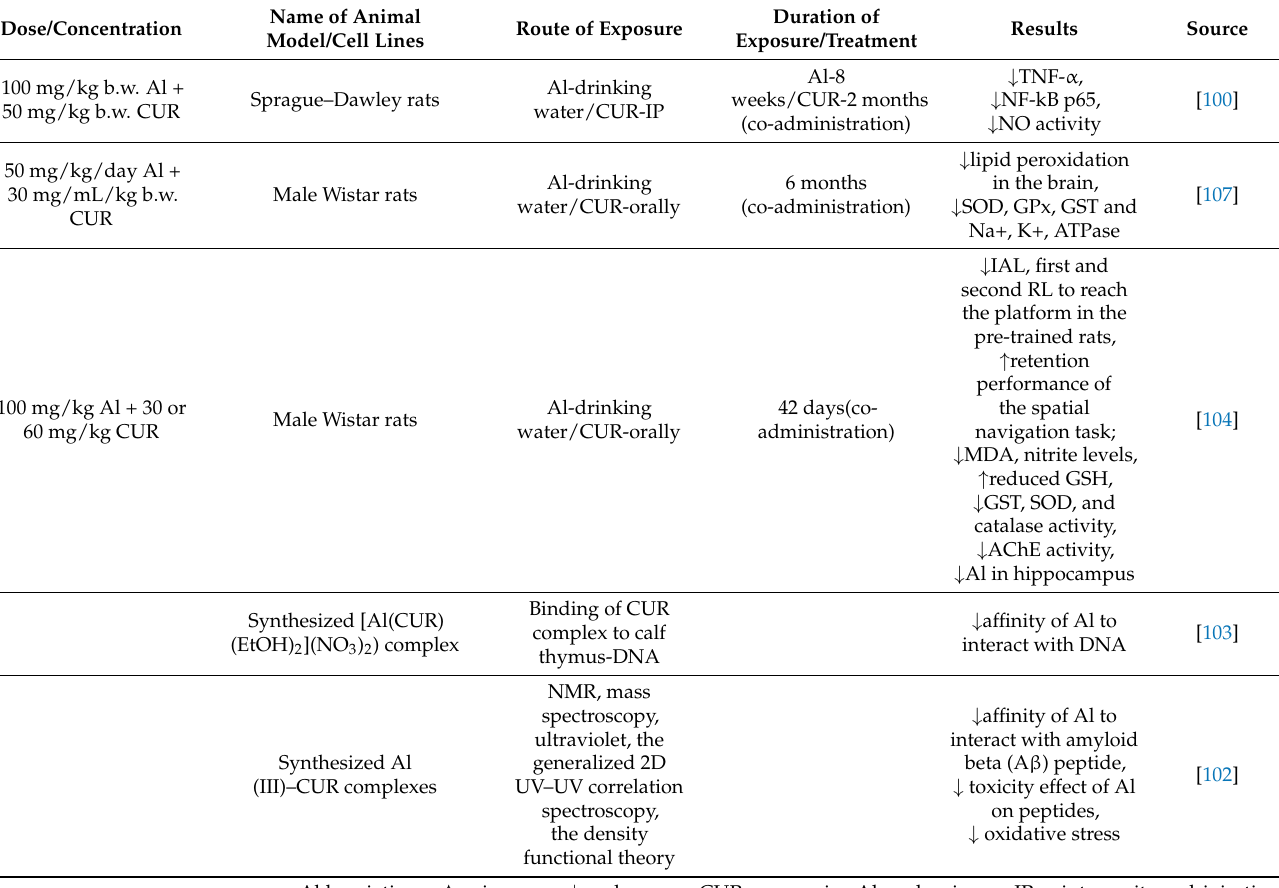
Table 2. Effects of curcumin on aluminum toxicity based on doses, experimental methods, and